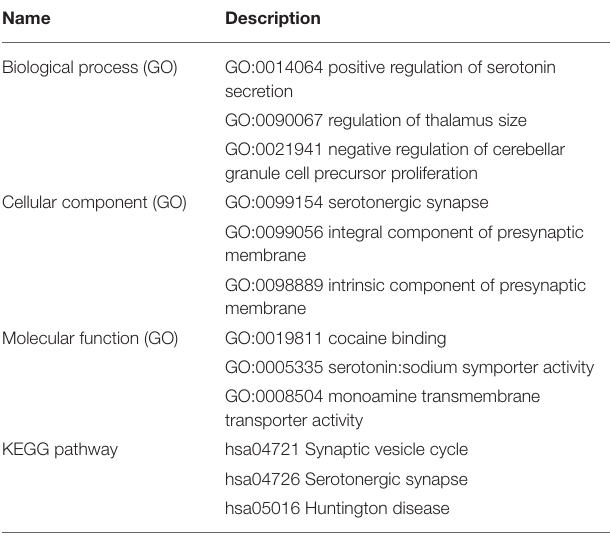
TABLE 2 | Functional relevance of the SLC6A4 gene based on GO database, where up to three most informative GO terms were kept, and KEGG pathway.